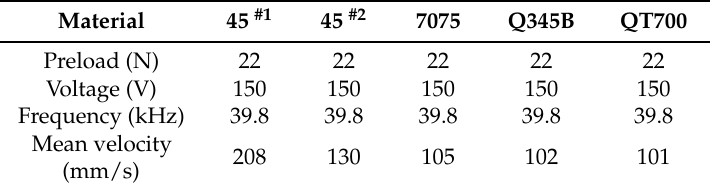
Table 2. Sliding conditions of ultrasonic motors consisted of metallic tips and